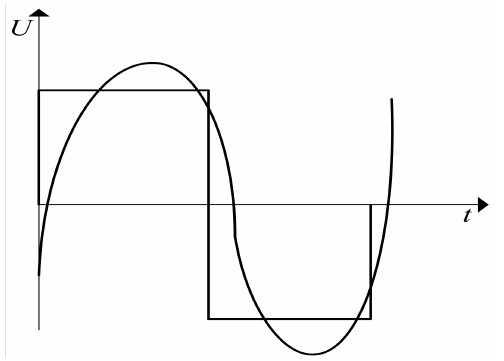
Figure 4. The working waveform of the full-bridge LLC resonant